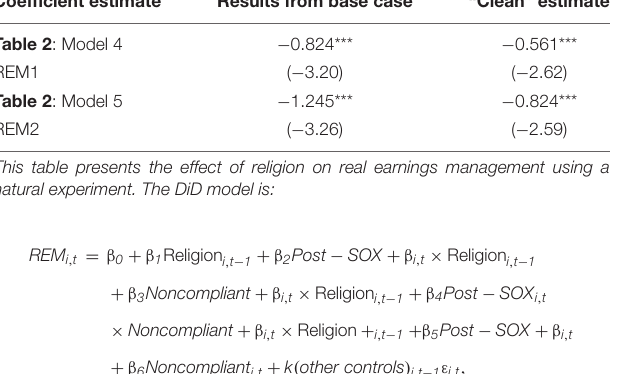
TABLE 3 | Difference-in-differences.